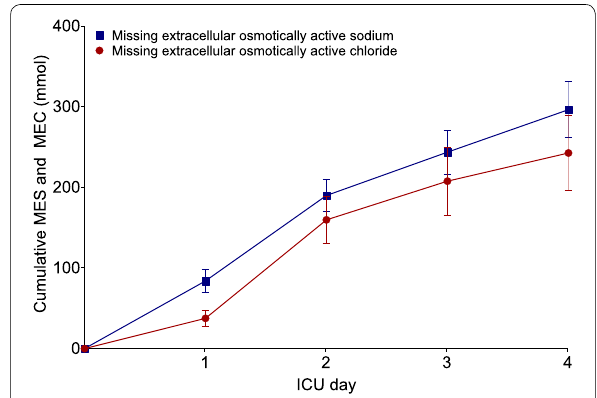
Fig. 1 Time course of estimated cumulative MES and MEC for the first four ICU days. Values are depicted as mean SE. The first values ± reflect levels at ICU admission, when storage was assumed defined as zero. The values at the subsequent time points reflect levels at the end (i.e., midnight) of each ICU day. As can be seen under normal and stable circulating electrolyte levels (Table 2), a significant amount of sodium (MES) and chloride (MEC) ‘disappears’ from the balances over the first four ICU